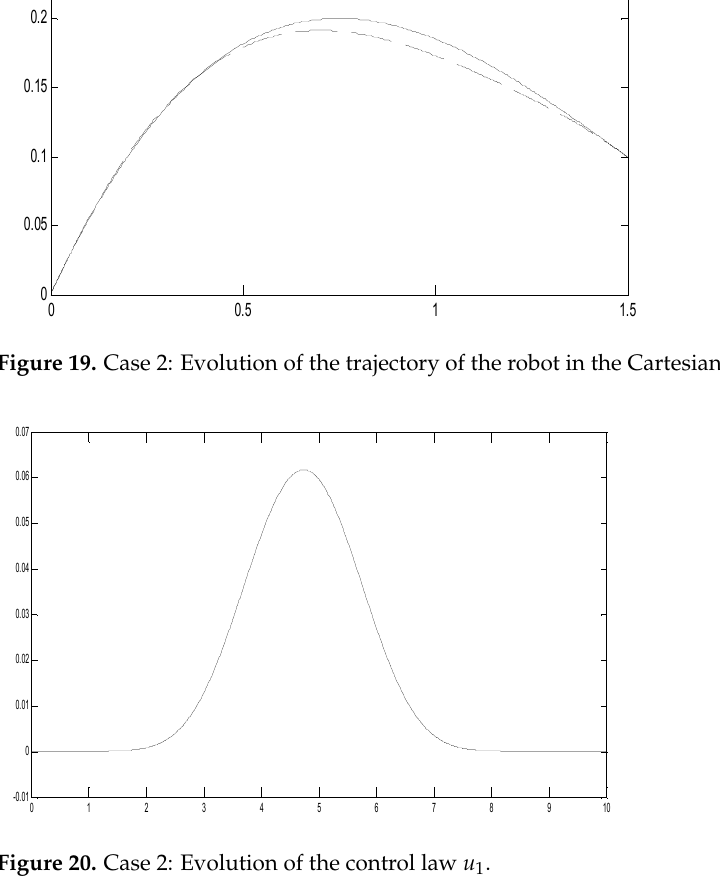
Figure 20. Case 2: Evolution of the control law u 1 .